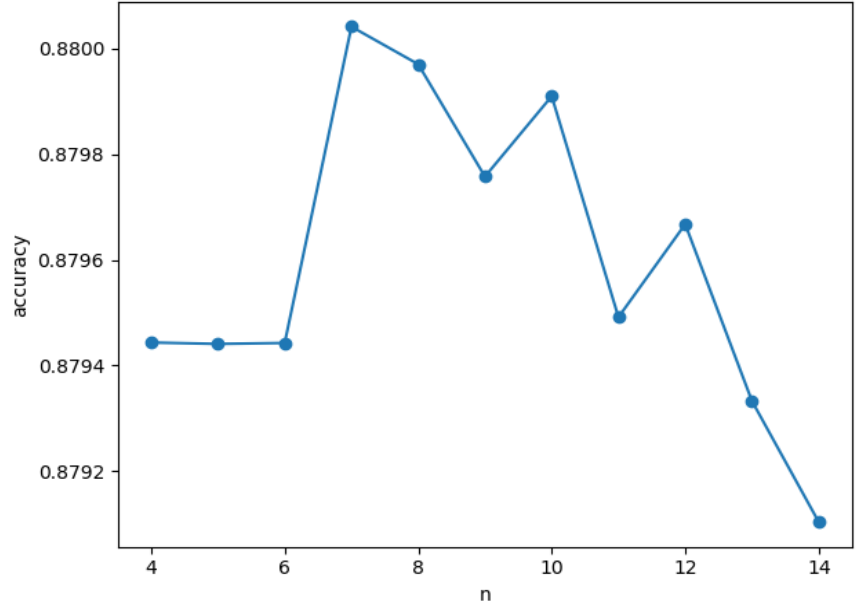
Figure 5. Relationship between n and accuracy when weight of ratio (w 1) = 0.15 and w 2 = 0.7.